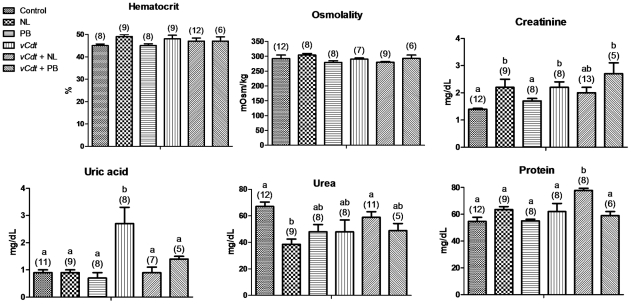
Effects of treatments on hematocrit and renal function parameters in the blood plasma.Mice treated with vehicle (control), allopurinol (NL), probenecid (PB) and Crotalus durissus terrificus venom (vCdt) followed by NL (vCdt+NL) or PB (vCdt+PB) after 2 h. Values are means ± SEM. Number of animals in parentheses. Comparison of the same parameter among groups: ANOVA (Hematocrit, p = 0.1807; Osmolality, p = 0.3577; Creatinine, p<0.006; Uric acid, p<0.0001; Urea, p<0.003; Protein, p<0.0001). Post hoc Student-Newman-Keuls (different letters over the bars indicate statistical differences: creatinine and urea, p<0.05; uric acid and protein, p<0.01).